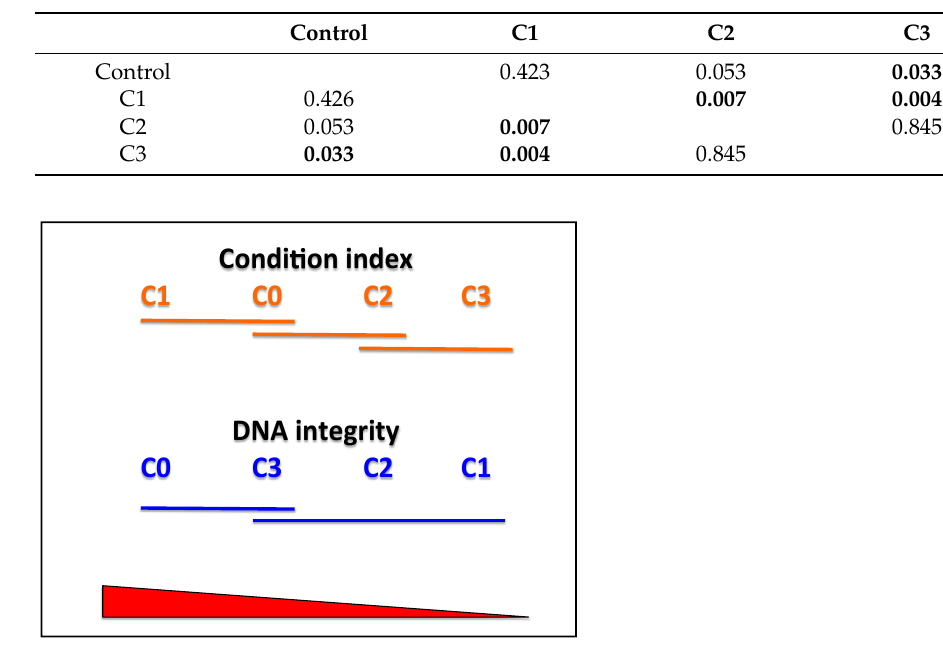
Figure 3. Graph showing the results of post-hoc tests for condition index (above) and DNA integrity (below) in the four experimental